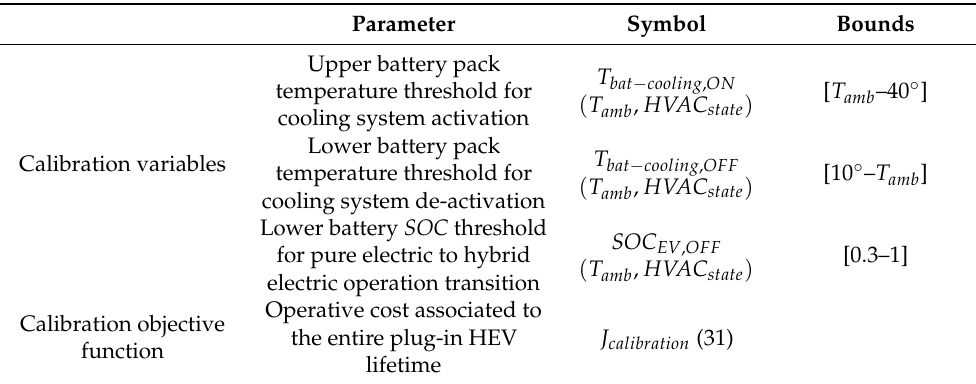
Table 4. Variables and objective function for the optimization based HEV energy and thermal management